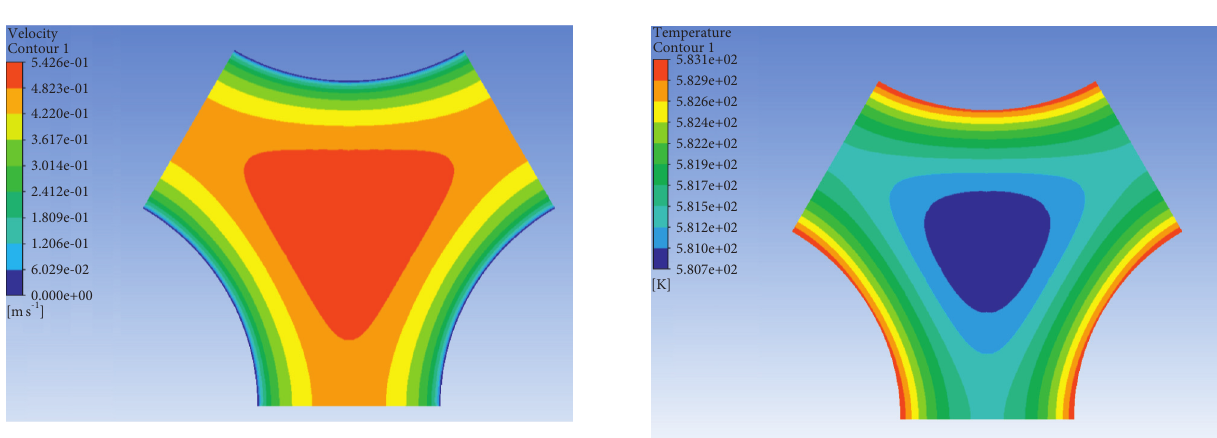
Figure 7: Velocity distribution.